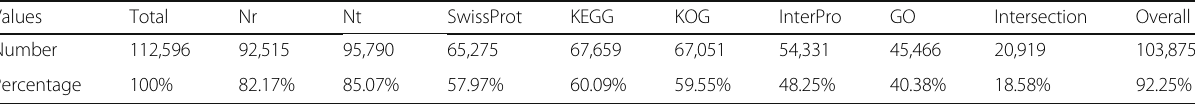
Table 3 Summary of functional annotation result, final isoforms were used to perform functional annotation with seven databases (Nr, Nt, SwissProt, KEGG, KOG, InterPro, GO)